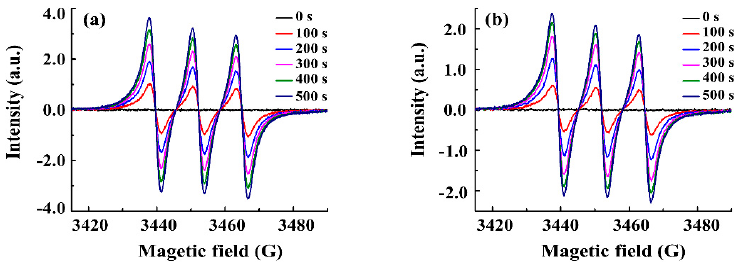
Figure 6. EPR spectra of the trapped NO from Ru-Lbpy 1 ( a ) and Ru-Lbpy 2 ( b ) in the presence of HSA with Hg lamp irradiation at 0 s, 100 s, 200 s, 300 s, 400 s, 500 s, respectively.